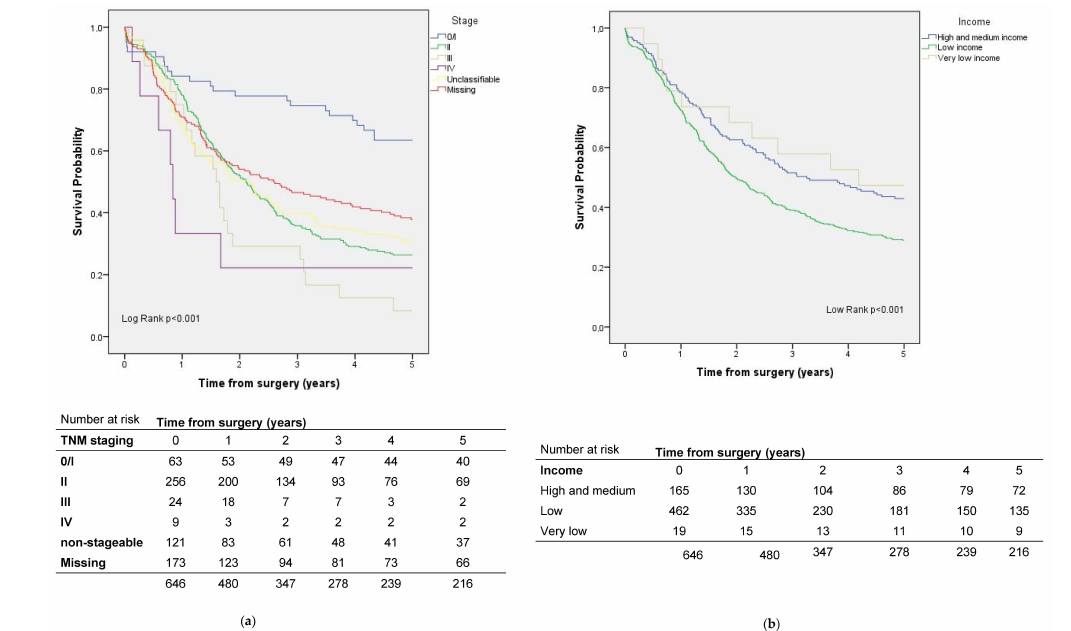
Figure 4. Survival by ( a ) stage and ( b ) socioeconomic status in pancreatic cancer